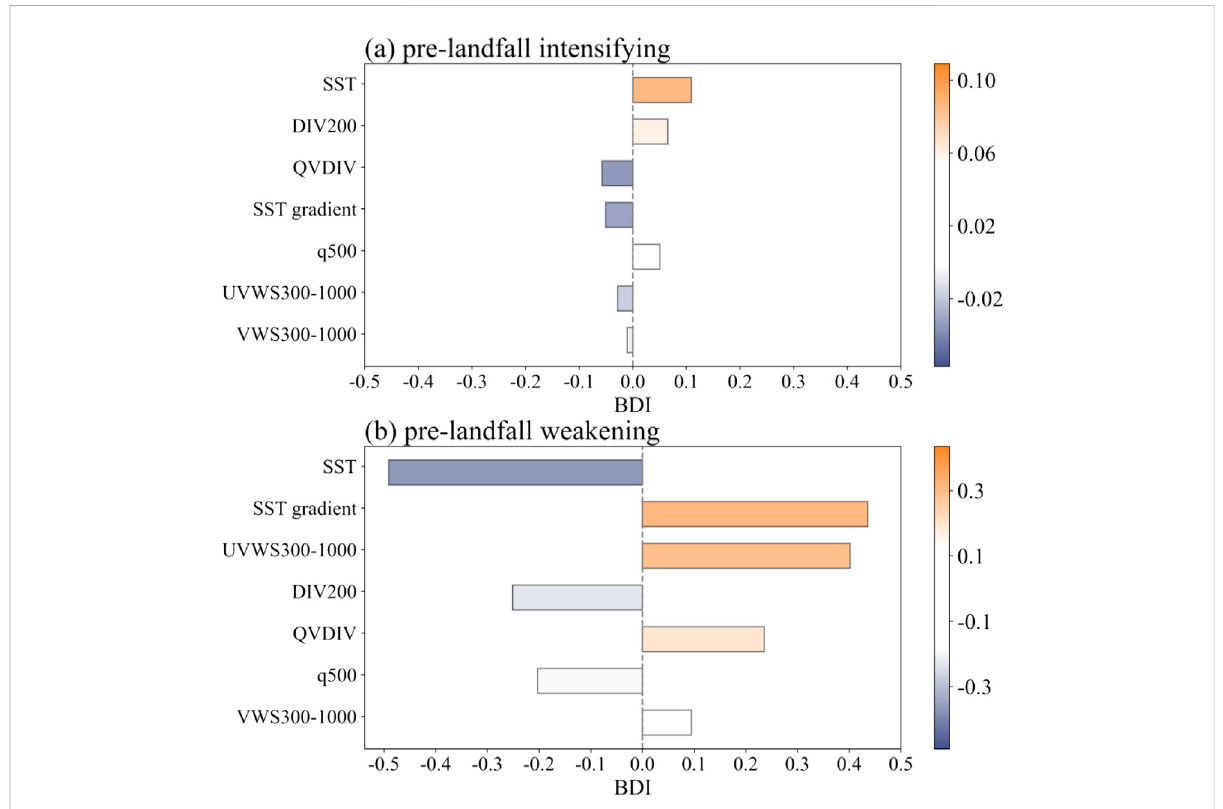
FIGURE 7 Key factors in (A) intensifying TCsand (B) weakening TCs and their corresponding box difference index(BDI) valuesprior to landfall. The factors are ordered based on the average values within 18 h prior to